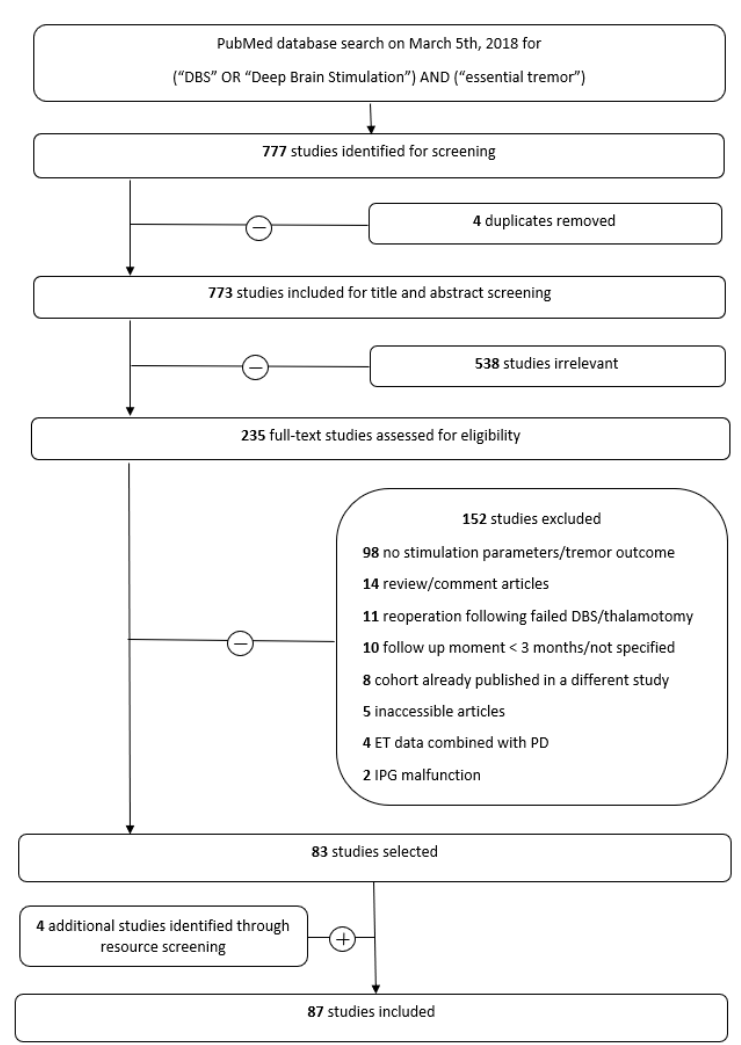
Figure 1. Preferred Reporting Items for Systematic Reviews and Meta-Analyses (PRISMA) flowchart.